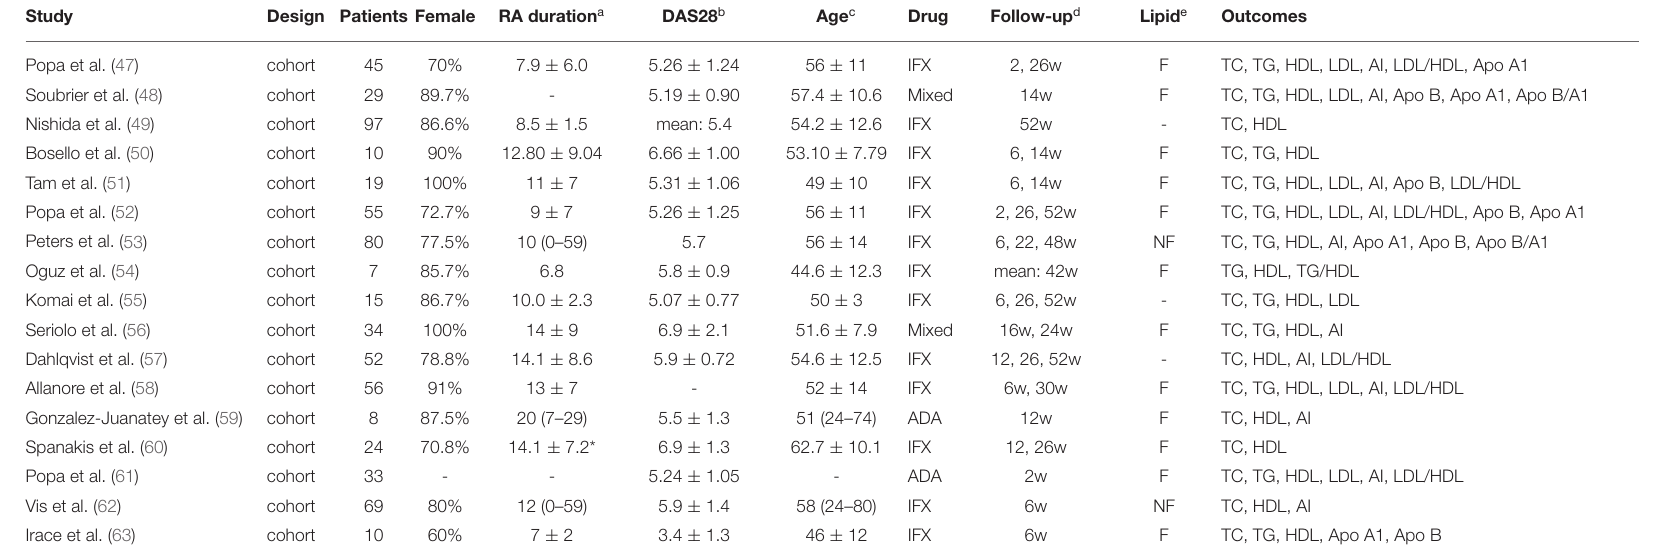
F TC, TG, HDL, Apo A1, Apo B a Data are mean ± SD, median [interquartile range (IQR)], range, median (range), or mean (range) in years, unless otherwise specified; * in months; # in days. b Data are mean ± SD, mean, median, median (IQR), or median (range), unless otherwise specified; if both Disease Activity Score-28-C-reactive protein (DAS28-CRP) and DAS-28-erythrocyte sedimentation rate (DAS28-ESR) are provided, DAS28-ESR is presented. c Data are mean ± SD, median (IQR), or median (range) in years unless otherwise specified. d When follow-up duration is not presented as weeks, convert it to weeks by using: 1 month = 4 weeks, 3 months = 12 weeks, 6 months = 26 weeks, and 1 year = 52 weeks; only time points that are included in the meta-analysis are presented. e F = lipids measured by using the fasting blood samples; NF = lipids measured by using the non-fasting blood